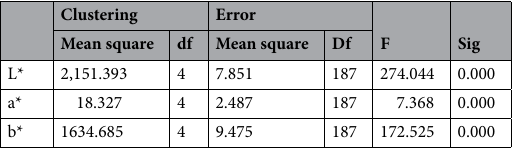
Table 4. ANOVA of L*, a*, and b* of citrine color stage.